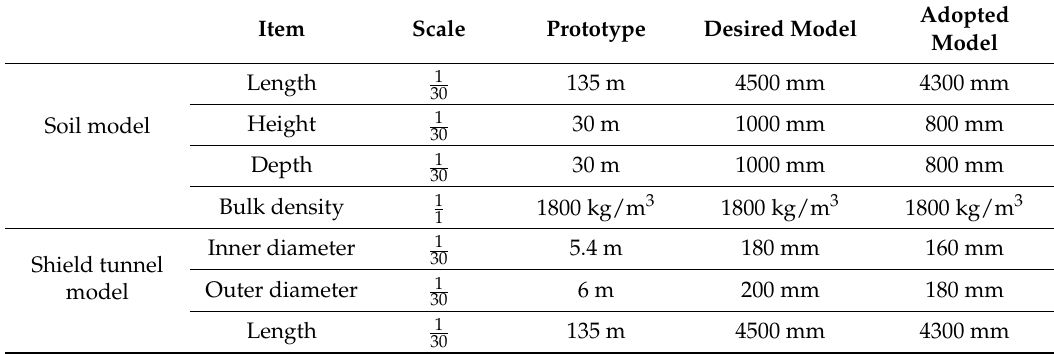
Table 1. The properties of aluminum model pipes considered in experimental verification.